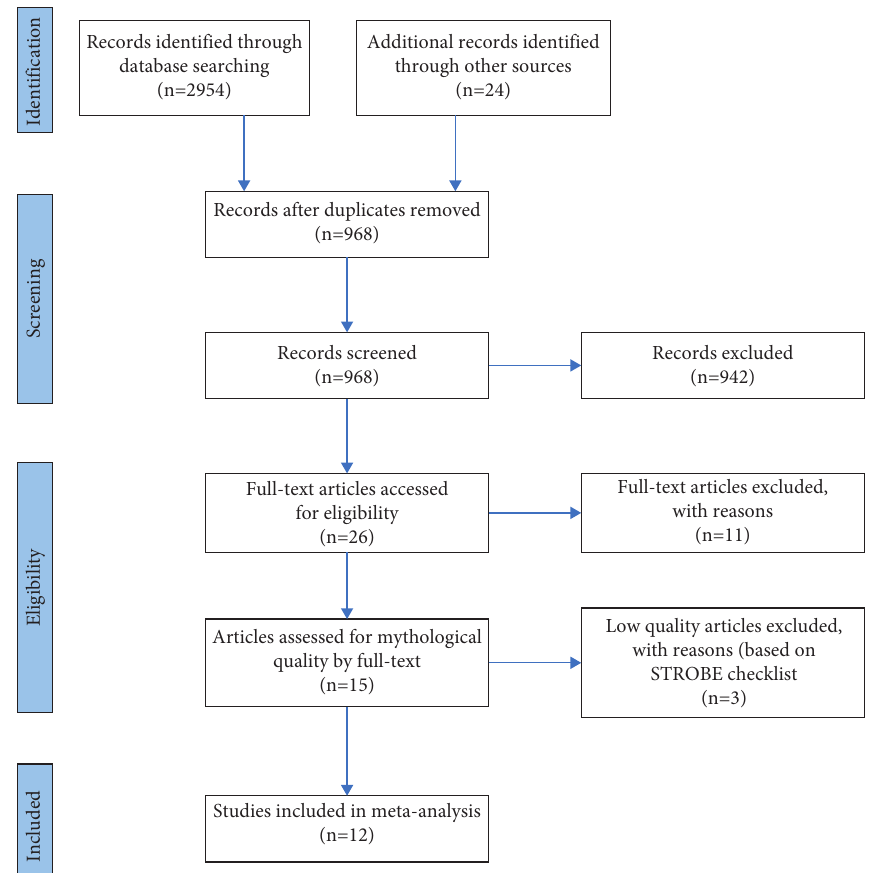
Figure 1: The flowchart of stages of inclusion of studies in the systematic review and meta-analysis (PRISMA